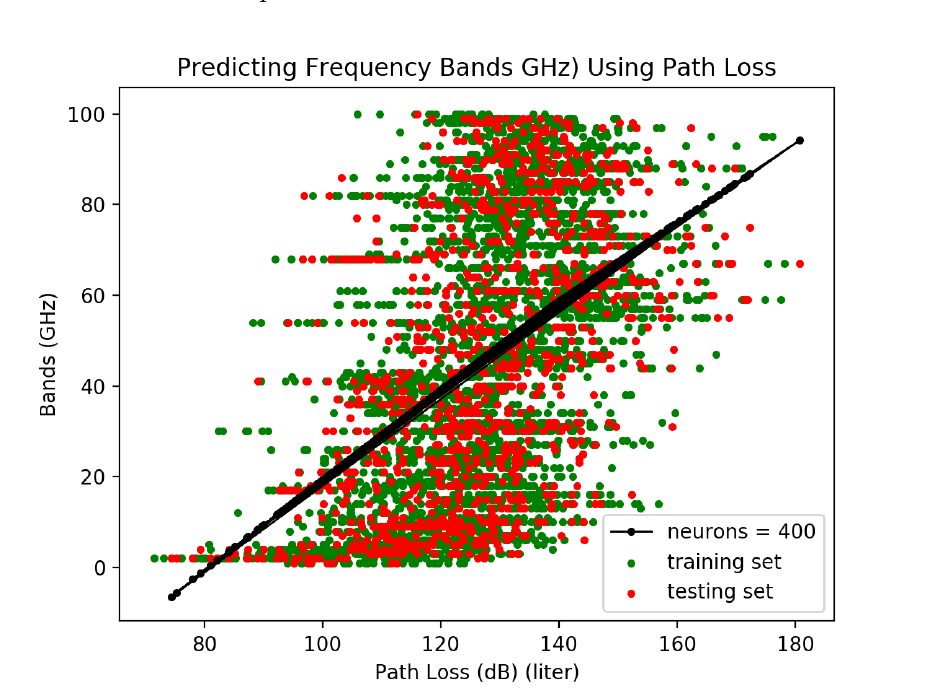
Figure 6. The relation of MmWave bands with path